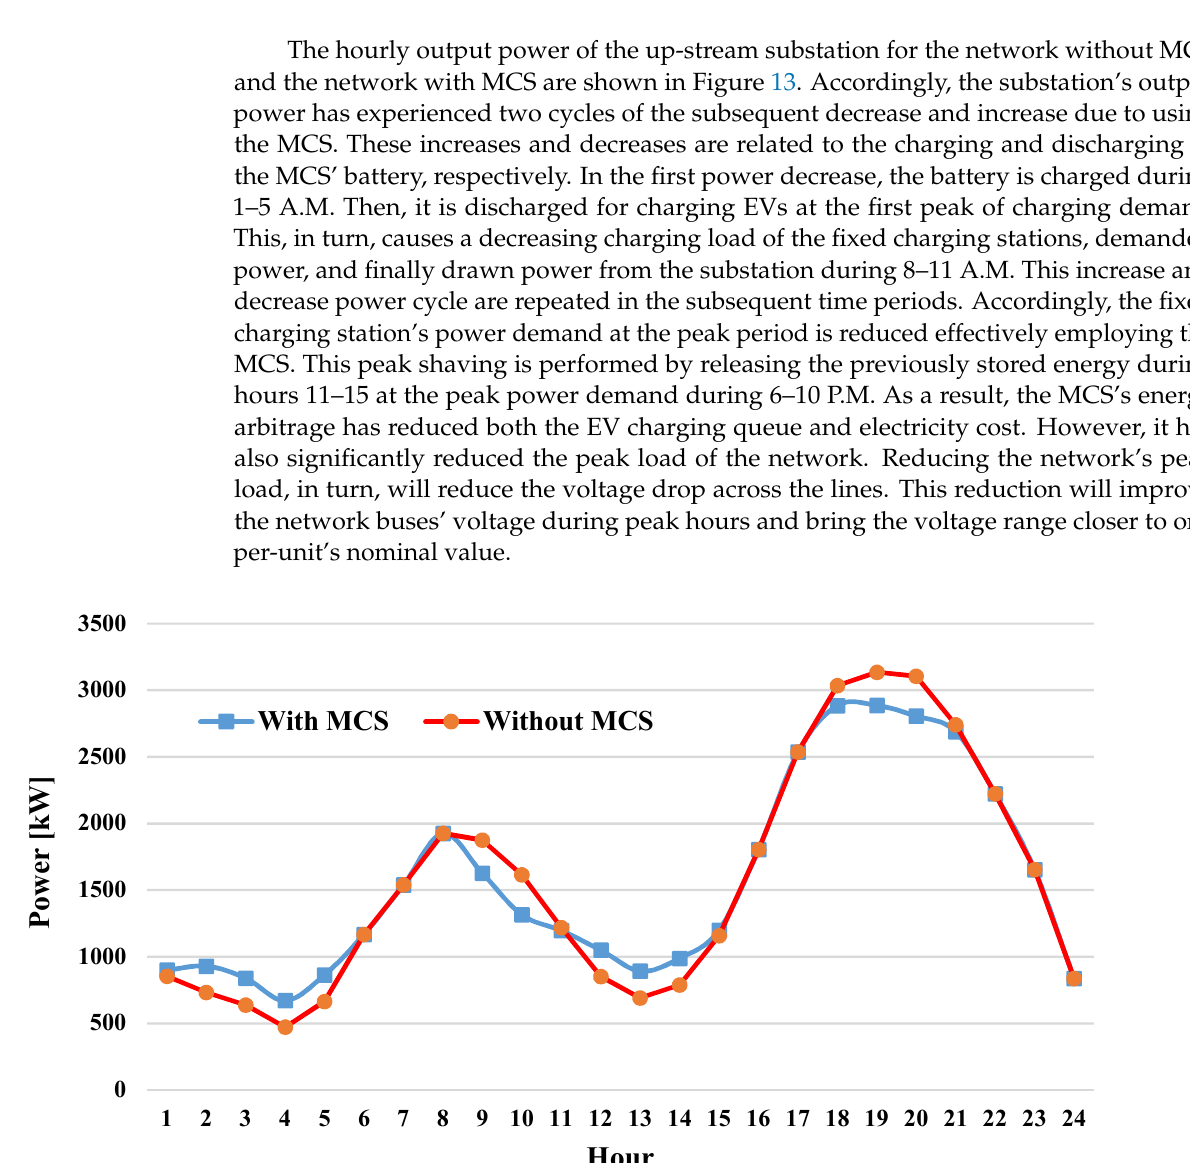
namely 8 PM. It validates the positive impact of the MCS optimal operation on the buses’ voltage. As can be observed, the voltage of the network buses demonstrates an increase at two time periods. This increase in the buses’ voltage directly results from the charging load reduction of the fixed charging station and lower power flow in the network lines.